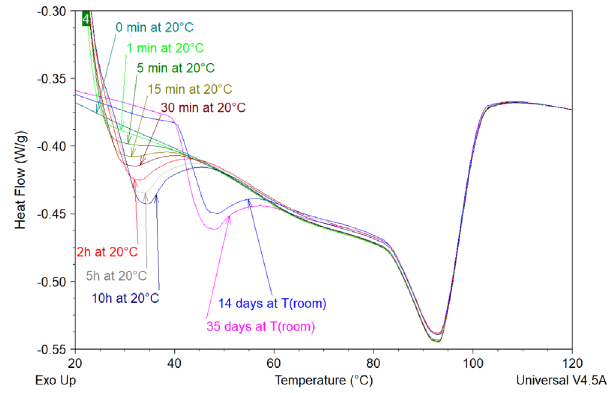
Fig. 4. DSC results of samples that have waited at 20 ° C during different amounts of time before being analysed. The glassy transition temperature of the polymer is (cid:1) 40